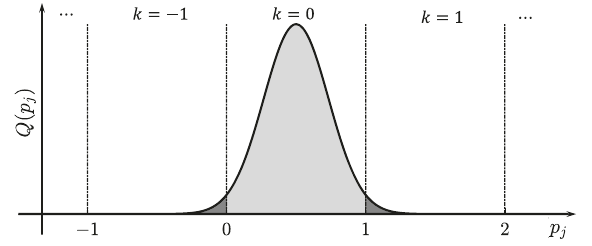
ffiffiffi p 2 Þð 0 j i